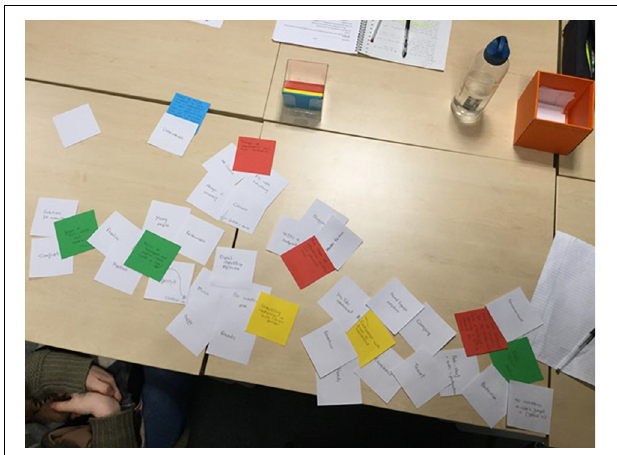
FIGURE 2 | Table setup developed for use during the creative task.